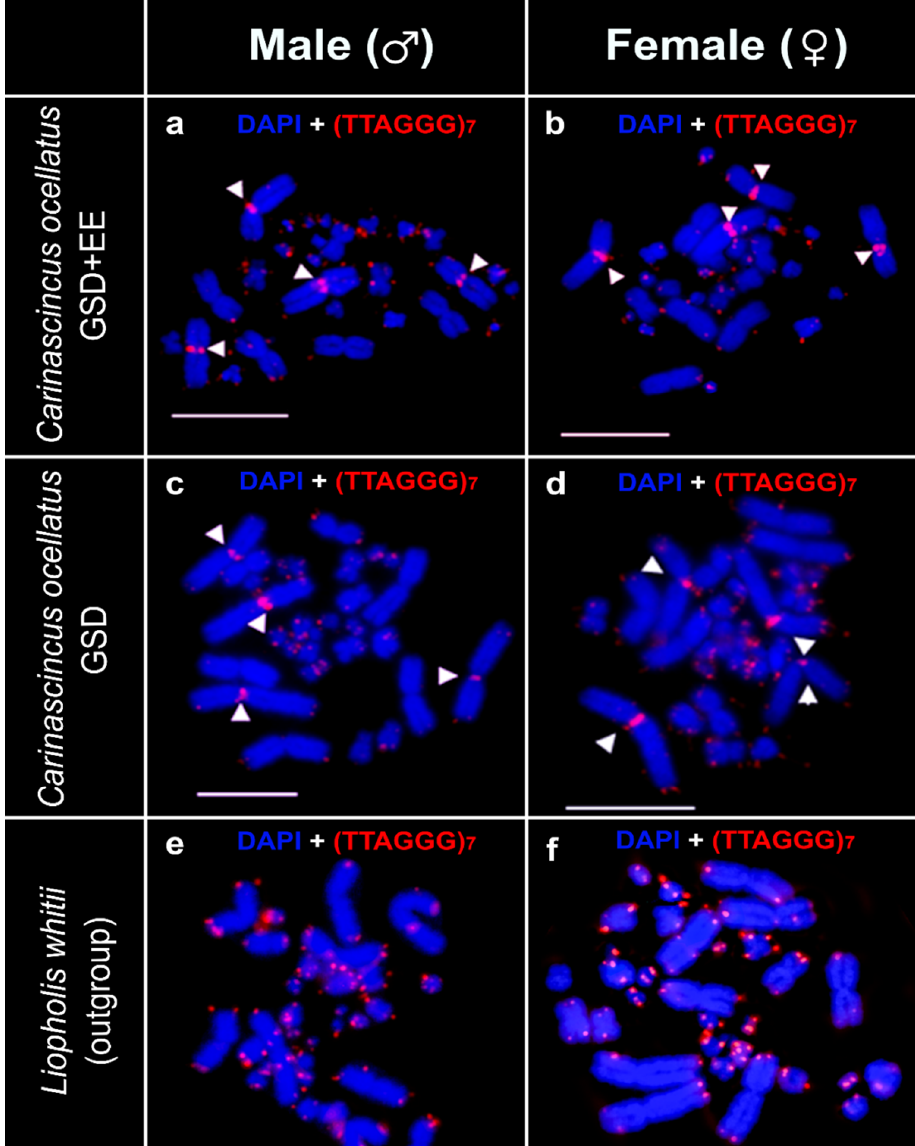
Figure 6. Chromosomal locations of the telomeric repeat (TTAGGG) 7 sequence (red) in Carinascincus ocellatus GSD+EE (low elevation) male ( a ) and female ( b ), GSD (high elevation) C. ocellatus male ( c ) and female ( d ) and Liopholis whitii male ( e ) and female ( f ). White arrowhead indicates centromeric telomeres. Scale bars represent 10 µm.